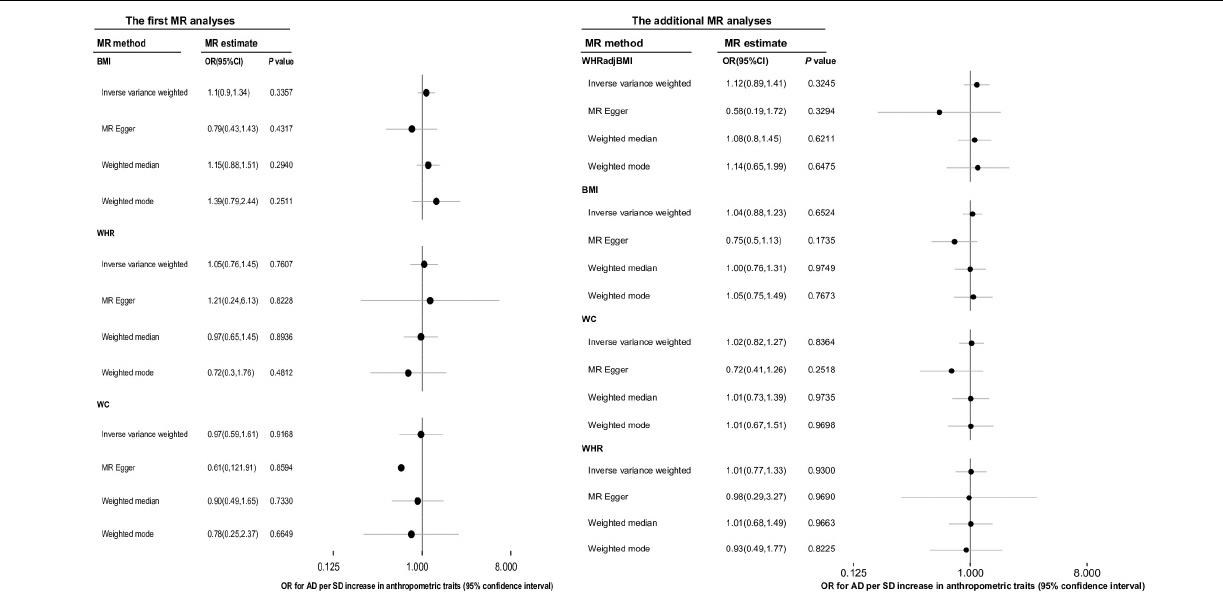
Frontiers in Neuroscience |